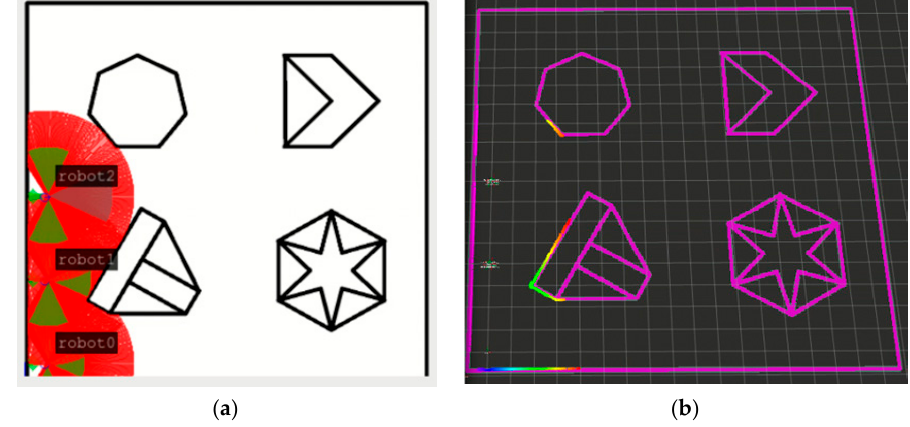
Figure 4. ( a ) The initial poses of the three mobile robots; ( b ) simulation visual interface of multiple mobile robots.